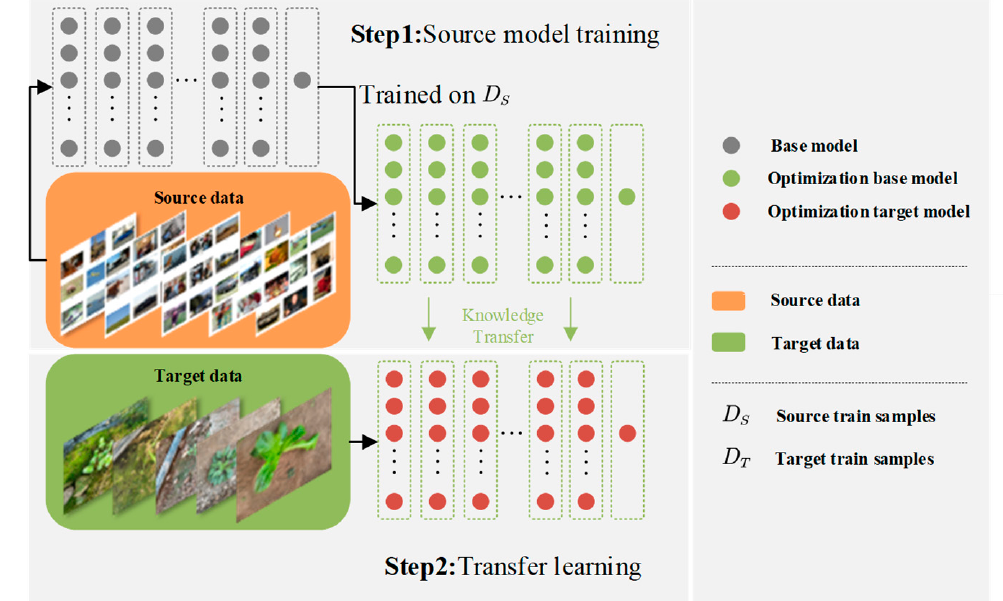
Figure 4. The process of transfer learning.